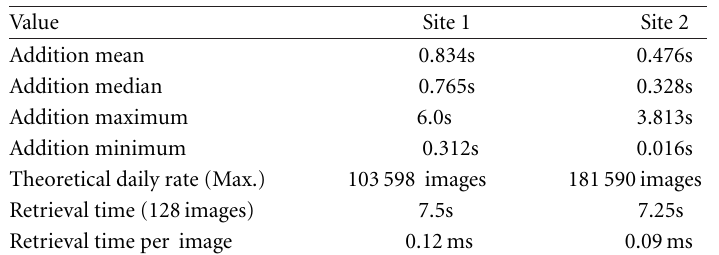
Table 3: Timing statistics for image addition and retrieval.